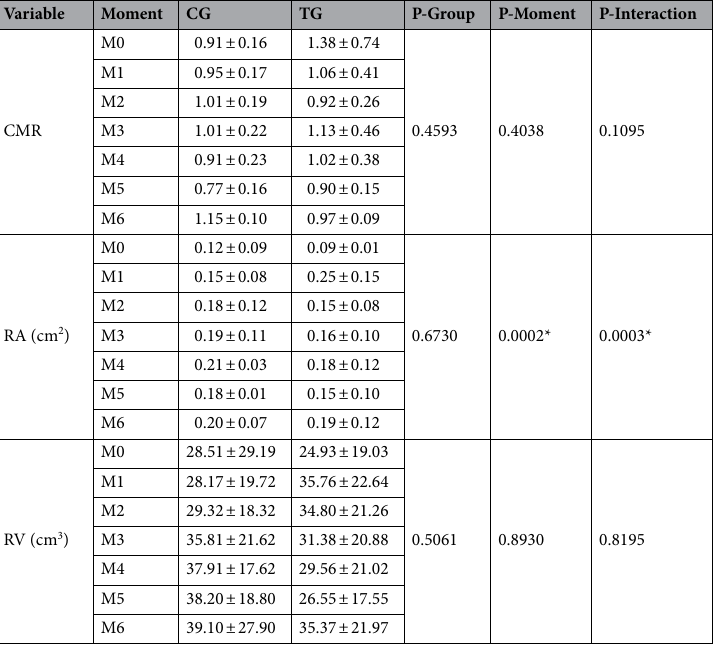
Table 1. Mean ± SD of B-mode ultrasound evaluation of the left kidney in bitches with mammary carcinoma treated (TG) or not treated (CG) with carprofen 4.4 mg/kg/day for 90 days and evaluated for 6 months. CMR: corticomedullary ratio; RA: area of the renal artery; RV: renal volume; * statistically